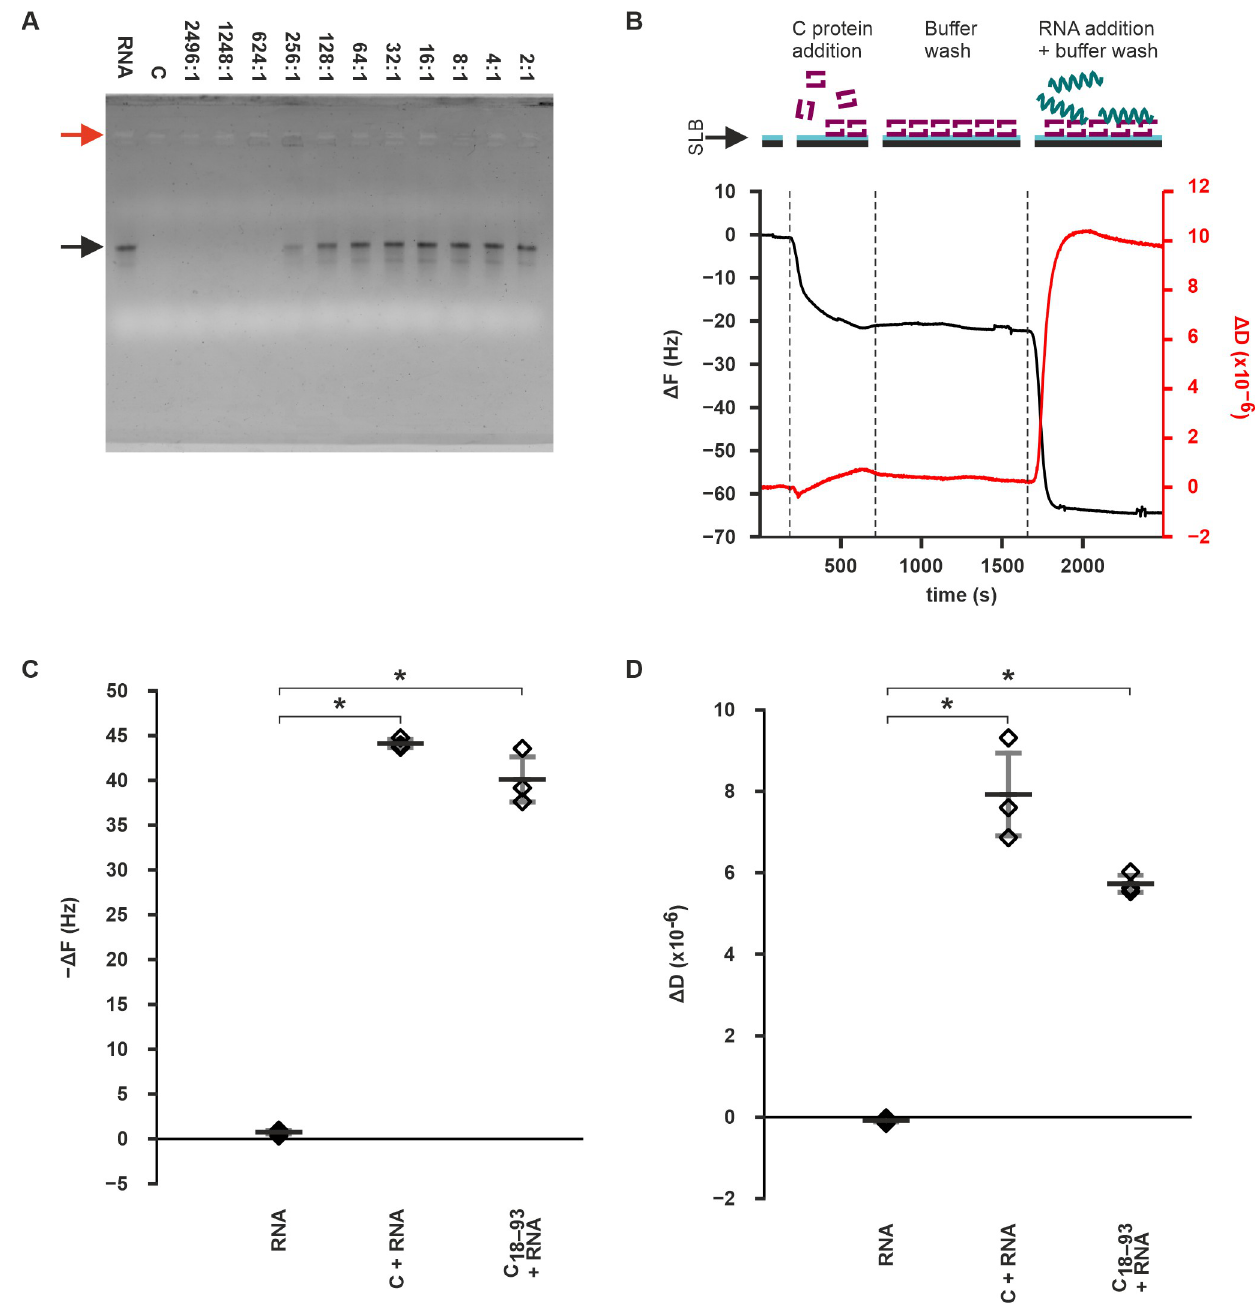
Fig 4. C protein can recruit RNA in solution and when bound on SLBs. A GEMSA gel showing C protein binding to RNA in solution. RNA refers to only RNA, and C to only C protein corresponding to the highest C protein concentration used. The C to RNA molar ratio is indicated. The black arrow indicates the bands of freely-migrating RNA, and the red arrow the wells. On lanes 624:1 and 256:1, RNA has been immobilized in the wells. B Representative QCM-D curves from an RNA-binding experiment on POPC/POPS SLBs with bound C protein. The Δ F and Δ D have been zeroed to equilibrium values after SLB formation. C, D Quantitation of Δ F ( C ) and Δ D ( D ) changes upon RNA insertion on SLBs pretreated with C, C 18–93 , or no protein. Data information. Data in C and D are shown as the mean of 3 repeats with s.d. represented by the error bars. Individual measurements are represented by the diamonds. Statistical significance (p < 0.05) is indicated with an asterisk. See the main text for the p-values.